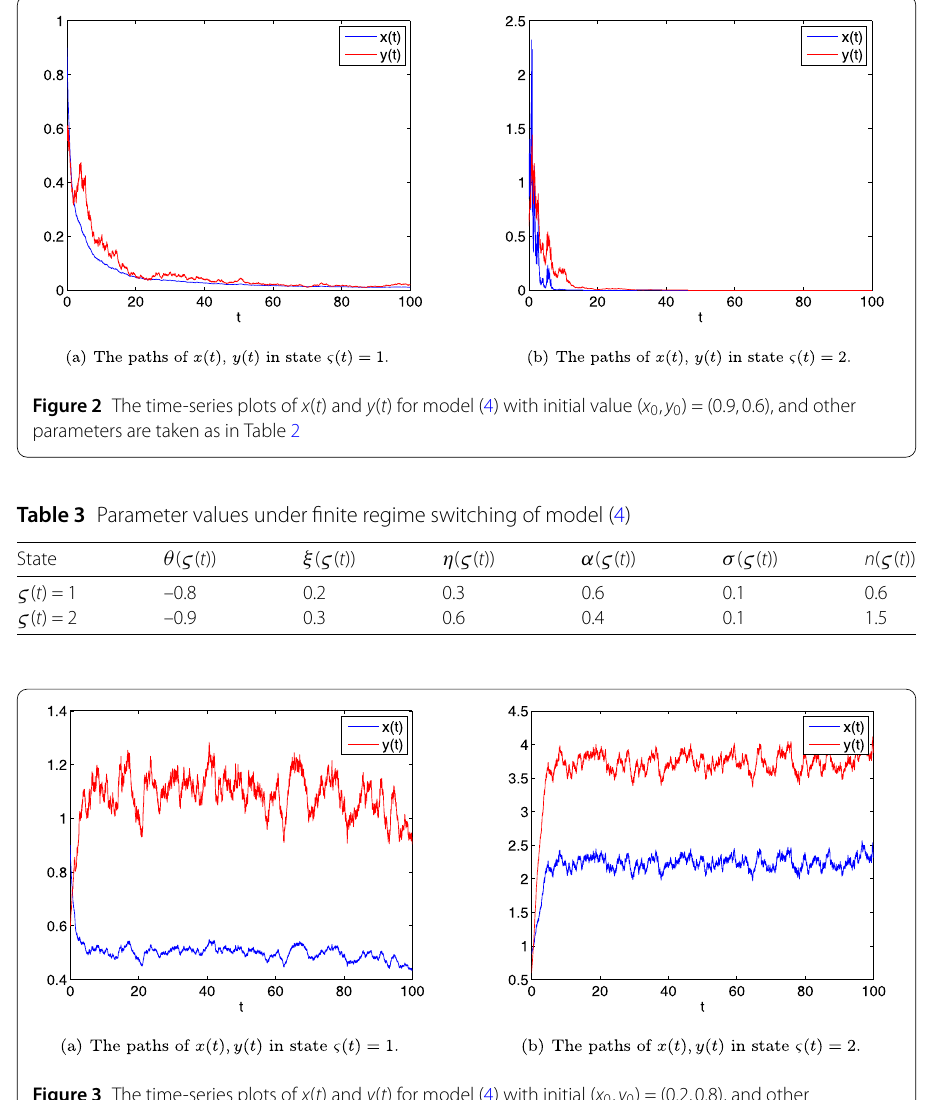
and y ( t ). The change in the stationary distributions with increasing σ is illustrated by the distributions displayed in the left ( σ = 0.1), middle ( σ = 0.4), and right ( σ = 0.9) panels in Fig. 4. The parameters of states 1, 2 and 3 are selected according to Table